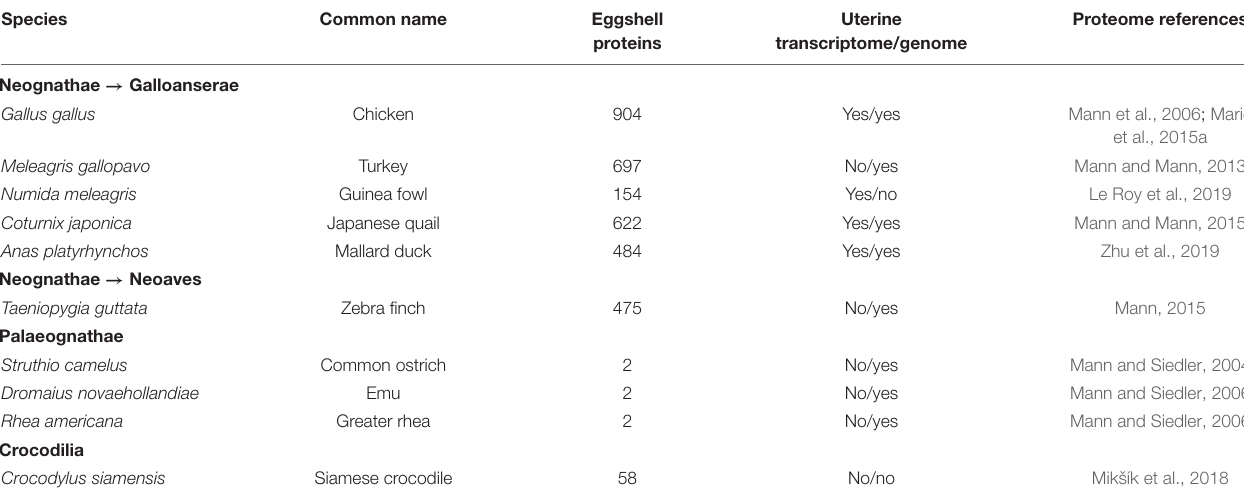
TABLE 1 | List of eggshell proteomes and the presence of transcriptome/genome in bird and reptile species. Species Common name Eggshell